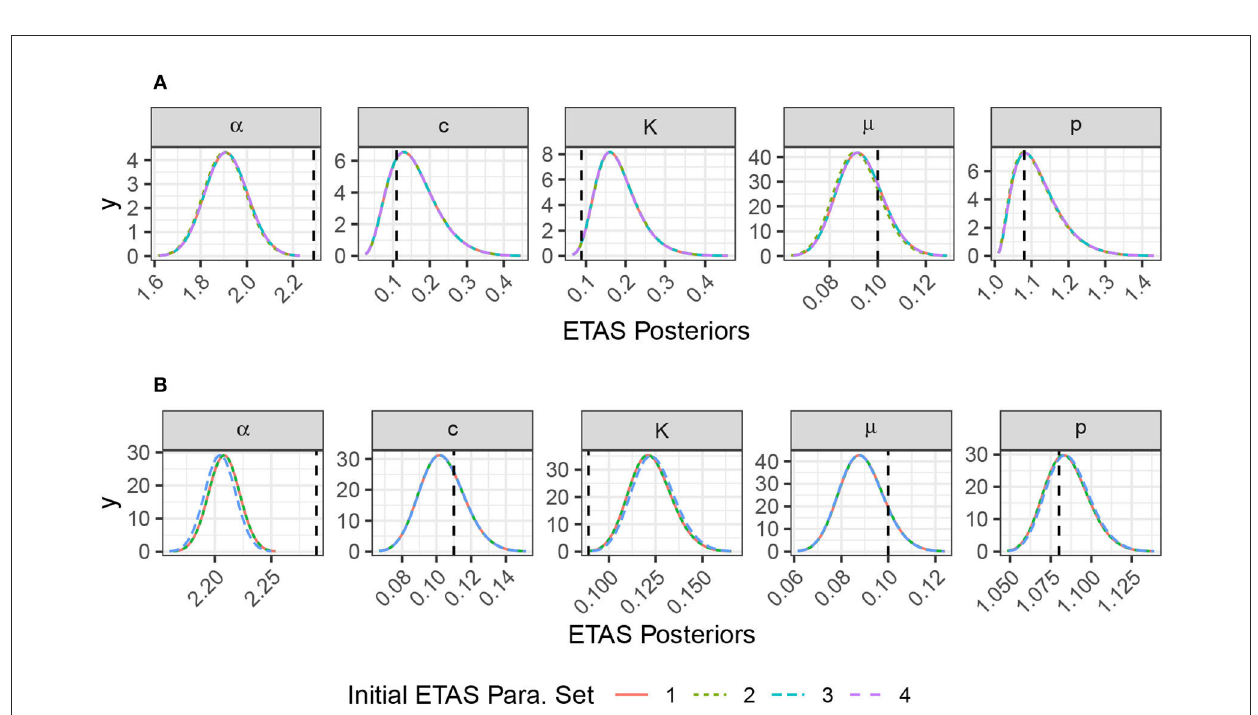
FIGURE4 Posteriors for the inversion of the catalogs in Figure 3 are given four different starting points. The vertical black line shows the true values used when generating the synthetic catalogs. Note the very different scales on the x-axis. (A) Inversion of a 1,000-day catalog with no large events, nEvents